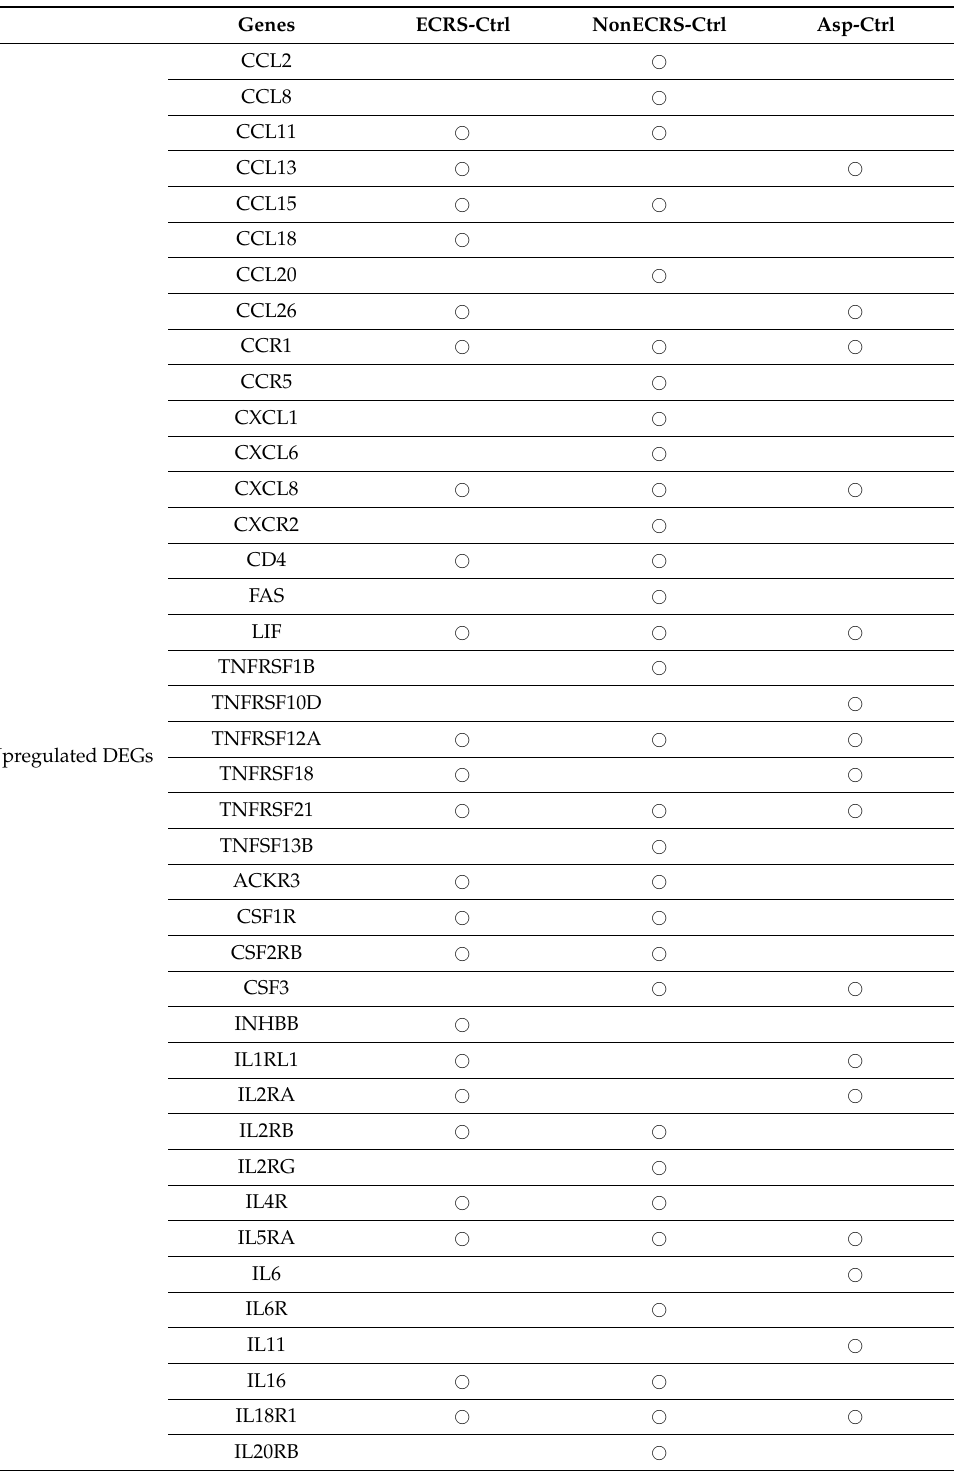
Table 2. Upregulated genes for “cytokine–cytokine receptor interaction.” Upregulated DEGs were represented with . CCL13 , CCL18 , CCL26 , TNFRSF18 , INHBB , IL1RL1 , and IL2RA in ECRS-Ctrl (cid:35) were more upregulated compared to nonECRS-Ctrl, and CCL2 , CCL8 , CCL20 , CCR5 , CXCL1 , CXCL6 , CXCR2 , FAS , TNFRSF1B , TNFSF13B , CSF3 , IL2RG , IL20RB , and IL23A in nonECRS-Ctrl were more upregulated compared to ECRS-Ctrl. The upregulated genes in Asp-Ctrl were similar to the DEGs of ECRS-Ctrl and nonECRS-Ctrl, but TNFRSF10D , IL6 , IL11 , IL31RA were only upregulated in Asp-Ctrl compared with the DEGs of ECRS-Ctrl and nonECRS-Ctrl. Genes ECRS-Ctrl NonECRS-Ctrl Asp-Ctrl CCL2 (cid:35) CCL8 (cid:35) CCL11